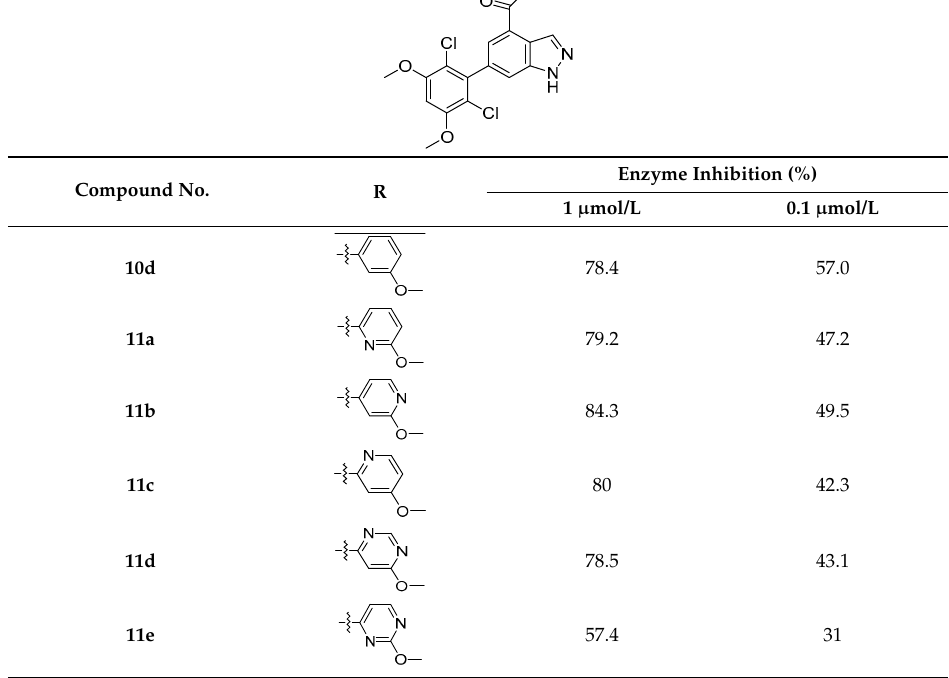
Table 2. Structures and activities of indazole derivatives 11a – e .